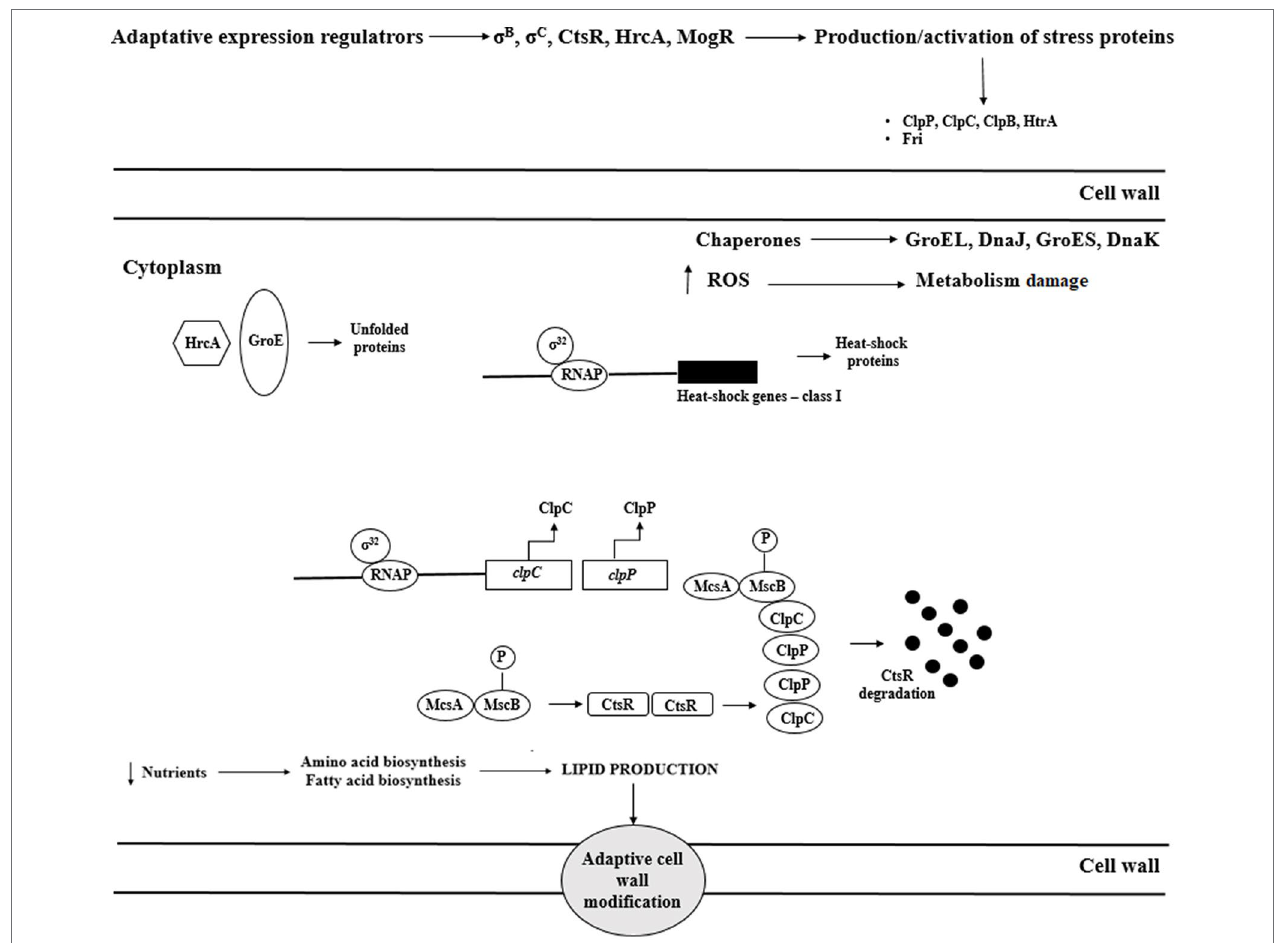
FIGURE 4 | Regulation of heat shock response of L. monocytogenes (ROS – reactive oxygen species; Msc – tyrosine kinase; McsA – zinger finger protein; HtrA – serine protease; ClpC – ATP-dependent Clp protease; HrcA – Heat-inducible transcription repressor; CtsR – negative transcription regulator; Fri – ferritin-like protein; and RNAP – RNA polymerase